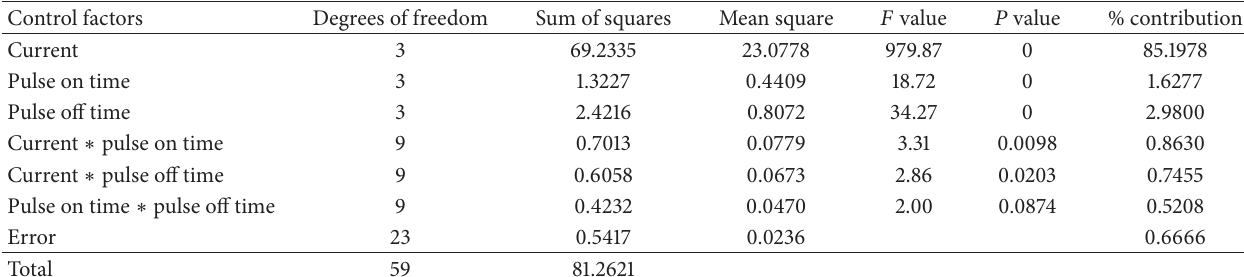
Table 2: ANOVA for